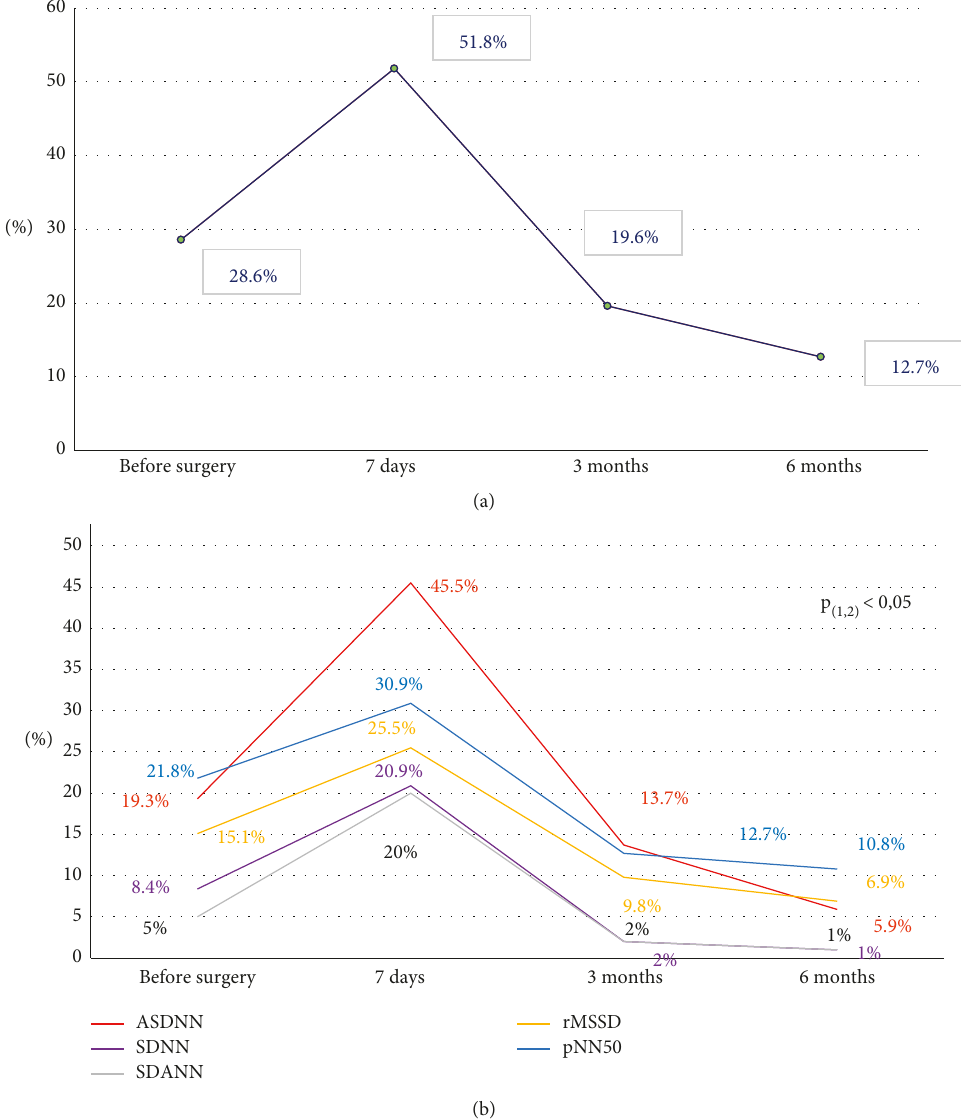
Figure 2: Heart rate variability. (a) Ratio of decreased heart rate variability before and after surgery and (b) ratio of decreased heart rate variability by each